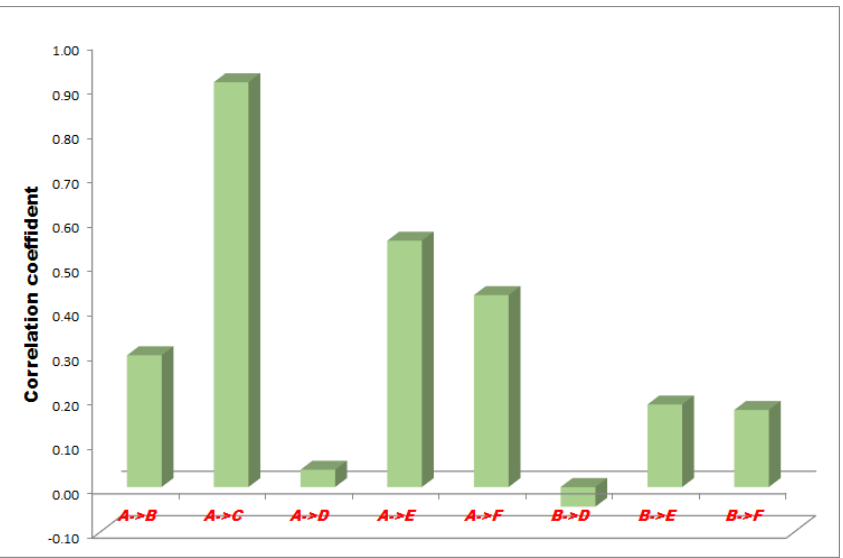
Figure 5. Results of statistical (correlation) analysis between the different sensor pairs during NPWT applying at 150 mmHg suction. Sensors represent exact measurement points in the abdominal cavity. A: midline, above the layer; B: midline, under the layer; C: laterally, above the layer; D: laterally, under the layer; E: midline, among the bowels; F: laterally, among the bowels.